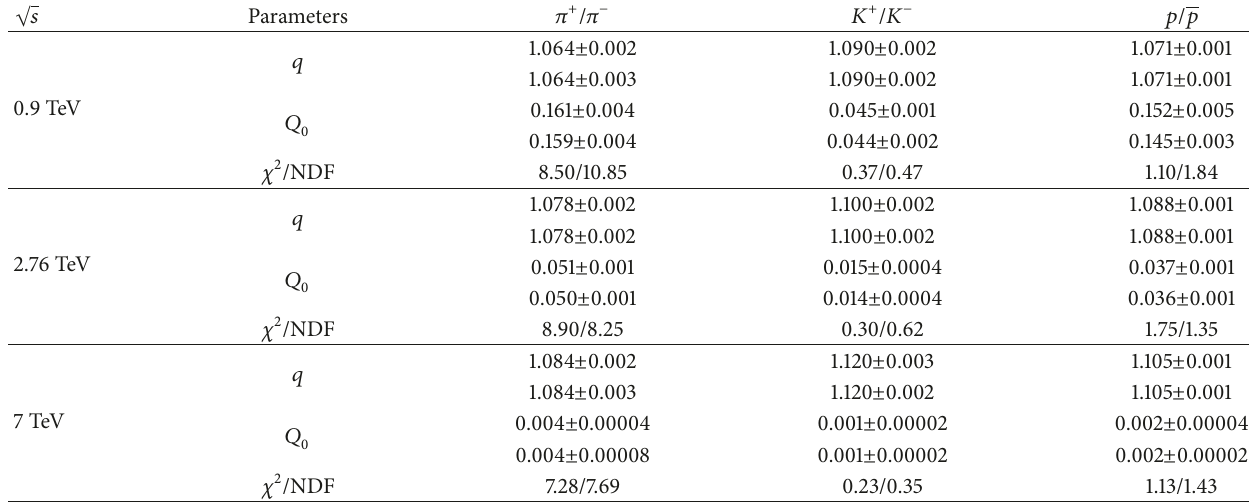
Table 3: The values of 𝑞 , 𝑄 0 , and 𝜒 2 /NDF obtained from the analyses of CMS data [46] in 𝑝 + 𝑝 collisions at LHC energies.